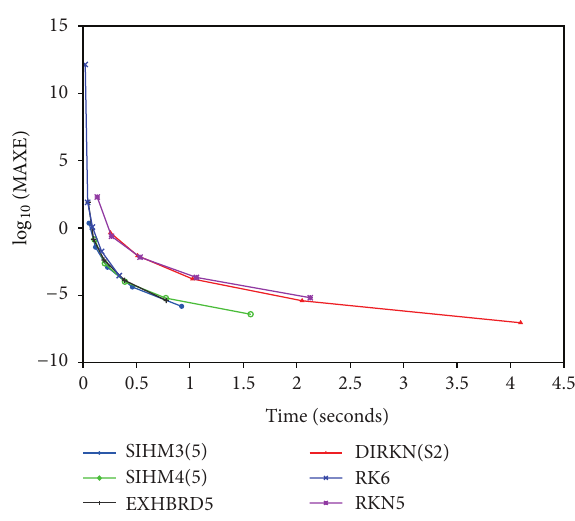
Figure 14: The efficiency curves for SIHM3 (5) and SIHM4 (5) methods for Allen and Wing problem with ℎ = 0.125/2 𝑖 , 𝑖 = 1, ...,5 .